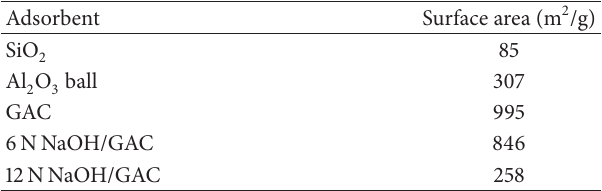
Table 2: BET-surface area of all